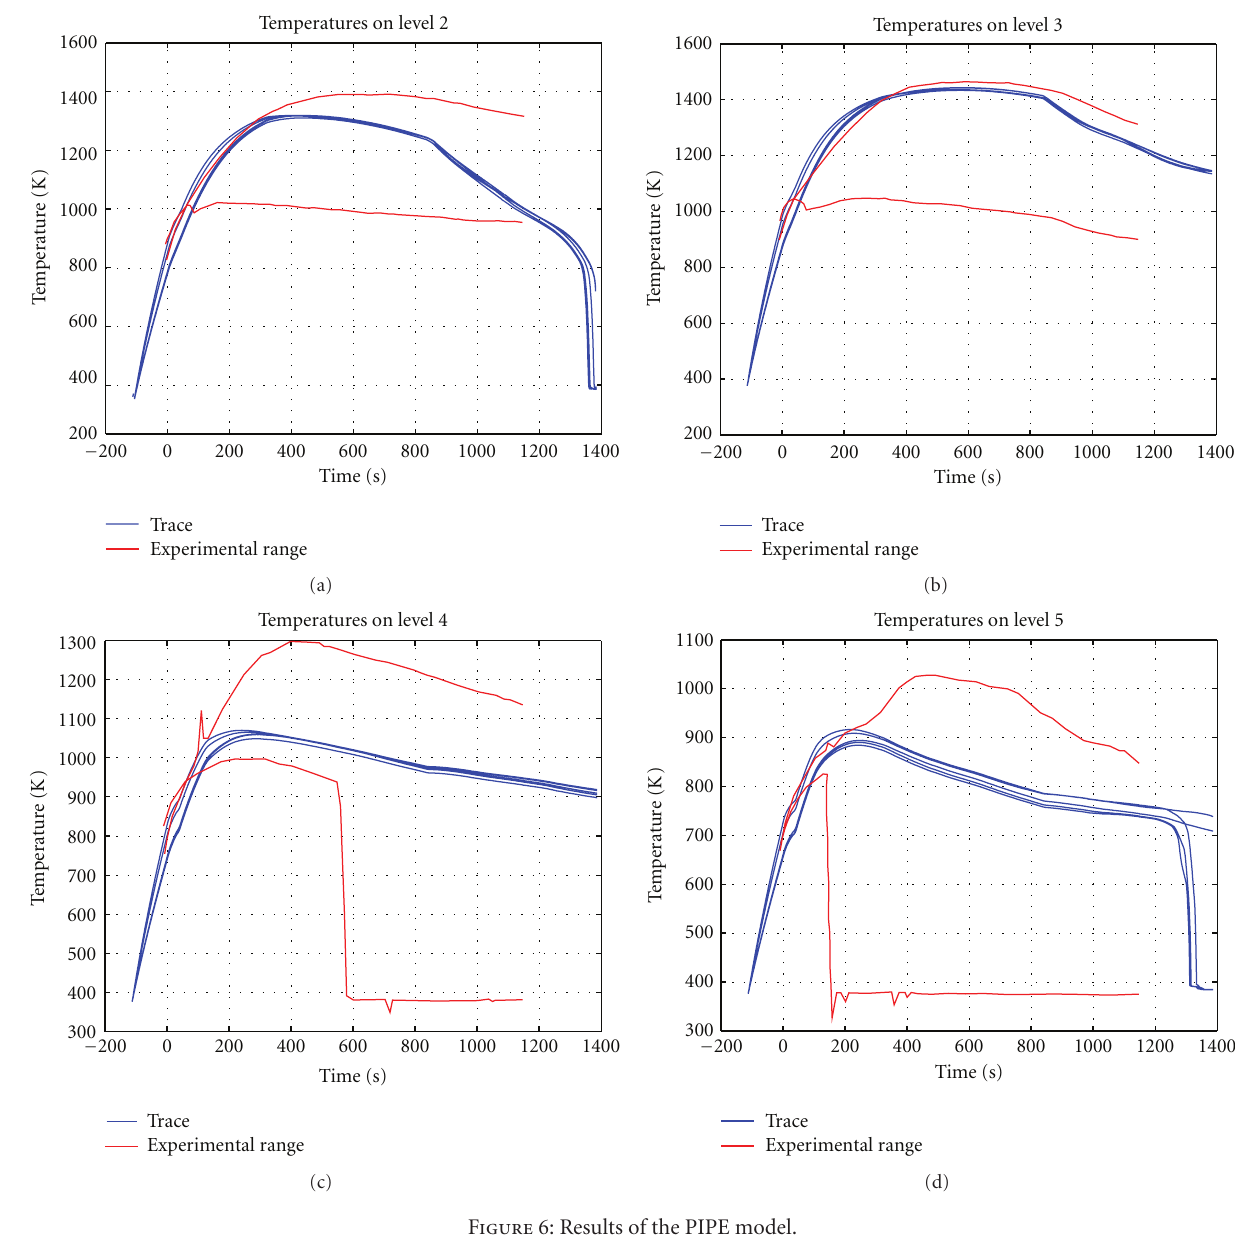
Figure 6: Results of the PIPE